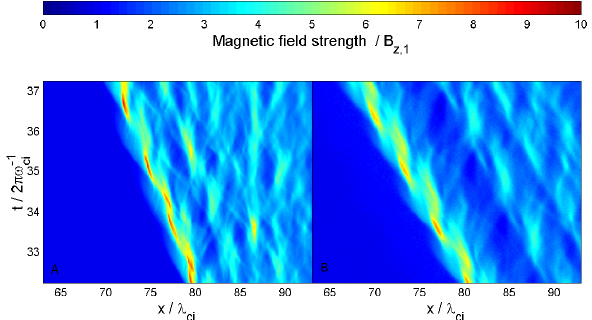
Fig. 1. Evolution of perpendicular magnetic field strength, over time (vertical axis), and space (horizontal axis), for a simulation in the absence of pickup ions (panel A) and a simulation containing 10% pickup ions (panel B).